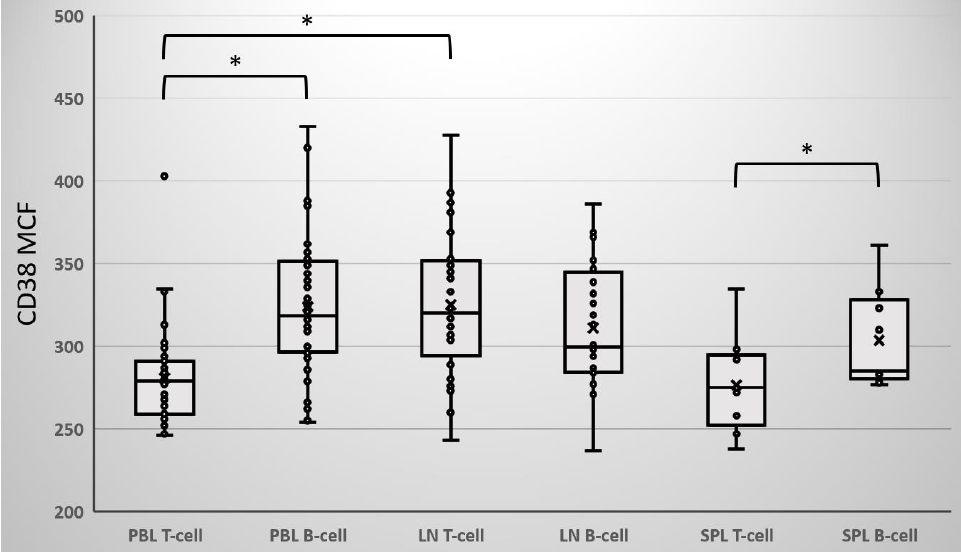
Figure 1. CD38 expression was highly variable depending on if T and B cells were isolated from peripheral blood (PBL), lymph nodes (LN), or spleen (SPL). The cell surface expression of CD38 was performed on pronase-treated T and B cells from 71 deceased and 7 living donors ( n = 78). Crossmatches were performed on pronased donor lymphocytes using a BD FACSLyric flow cytometer with staining of CD45/leukocyte, CD3/T, CD19/B, G46-2.6/HLA-I and Tu39/HLA-II. Cell surface CD38 expression was characterized using HB7 anti-human CD38 monoclonal antibody and analyzed in median channel fluorescence (MCF) values. Student’s t -test, * p < 0.001. Table 1. Donor lymphocyte treatment by 0.05 M of DTT for 10 min at 37 ◦ C effectively removed surface-bound CD38 and abrogated false-positive flow cytometric crossmatch (FCXM) outcomes caused by patient sera containing Daratumumab without affecting assay sensitivity and specificity. Values for the control sera and the HLA class I, HLA class II and CD38 expression are represented and analyzed in median channel fluorescence (MCF). Values for the five patient sera used in the surrogate donor crossmatches (in parentheses) are represented in median channel shift (MCS) from the negative control (i.e., patient serum MCF minus negative control MCF). Crossmatch outcomes were interpreted from MCS based on established positive cutoffs. NA, not applicable.